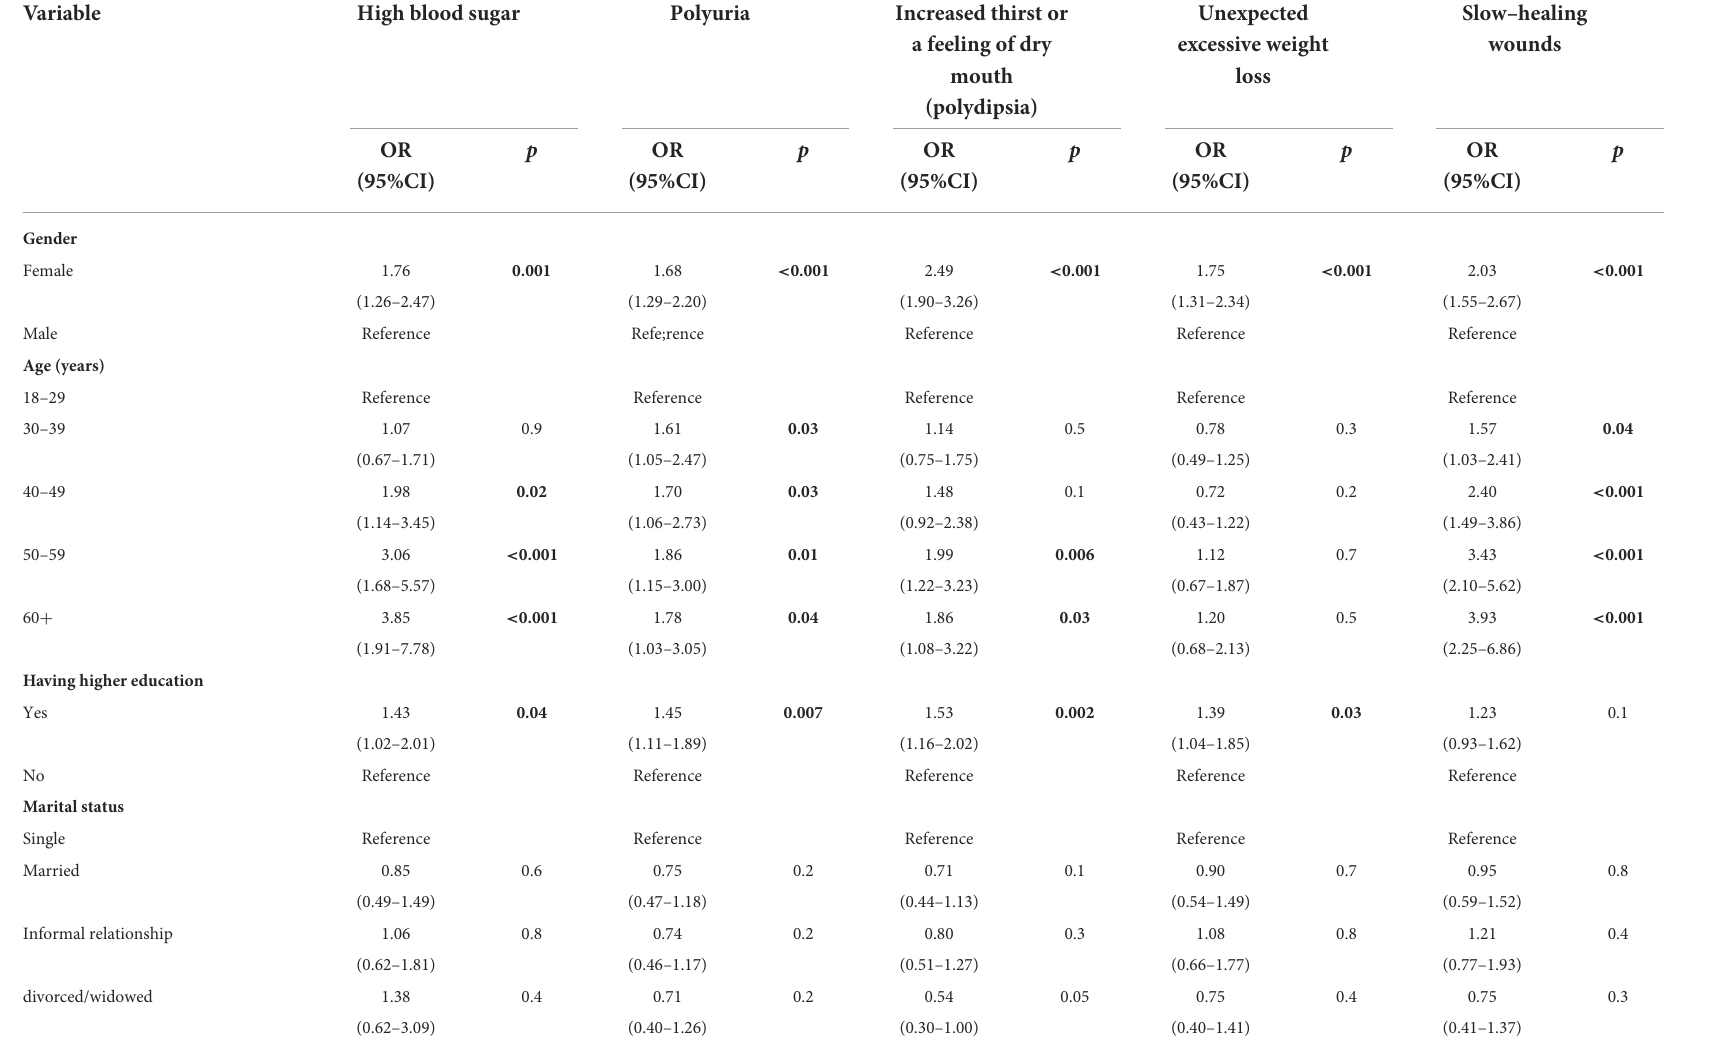
Factors associated with awareness of diabetes symptoms among adults in Poland